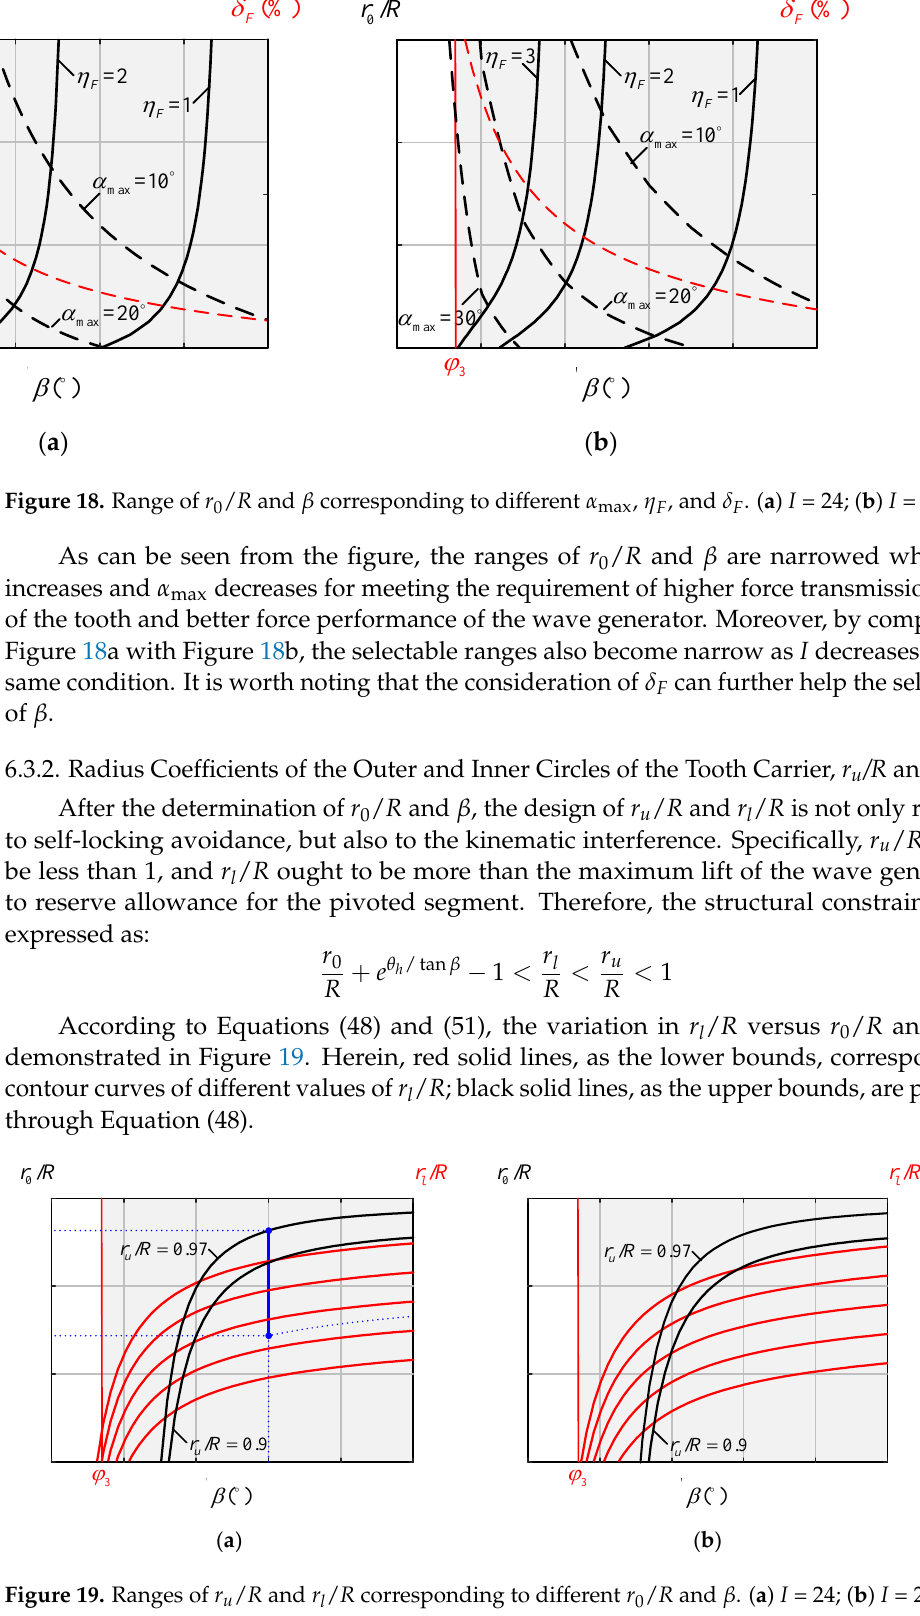
dotted lines represent different force transmission rates and maximum meshing angles, and red dotted lines denote the pulsation amplitude.